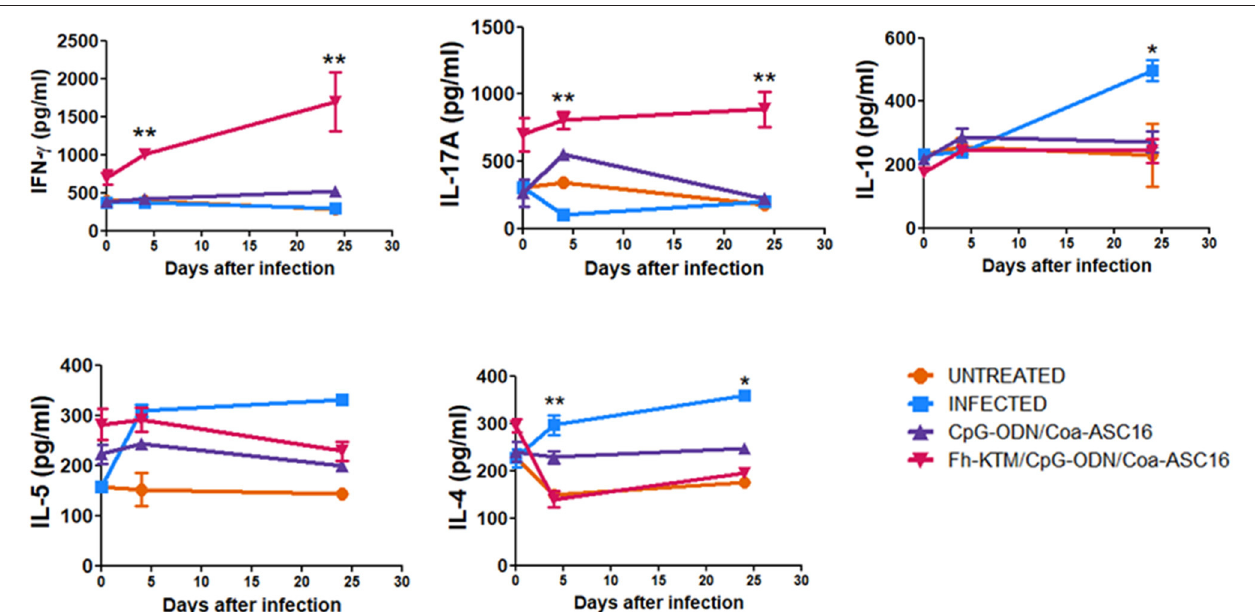
FIGURE 4 | FhKTM-specific cytokine immune responses in BALB/c mice after vaccination. At 0, 4, and 24 dpi, spleens were collected and splenocytes were stimulated in vitro with FhKTM for 72h. The culture supernatants from spleen cells were assessed for the production of IL-17A, IFN- γ , IL-10, IL-5, and IL-4 by ELISA. Results are shown as mean ± SD and levels of significance as indicated by p -values and are representative of two or three independent experiments. They were assessed by one-way ANOVA and Tukey’s multiple comparison tests * p < 0.05; ** p <